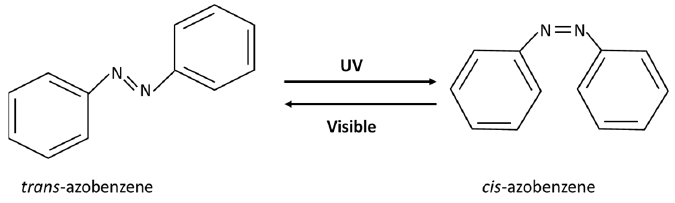
Figure 2. Azobenzene photo ‐ isomerization.